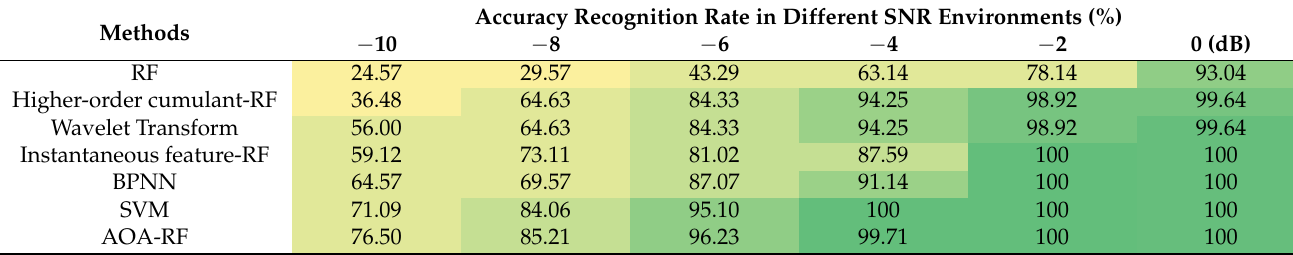
Table 3. Recognition accuracy of different methods under different SNR